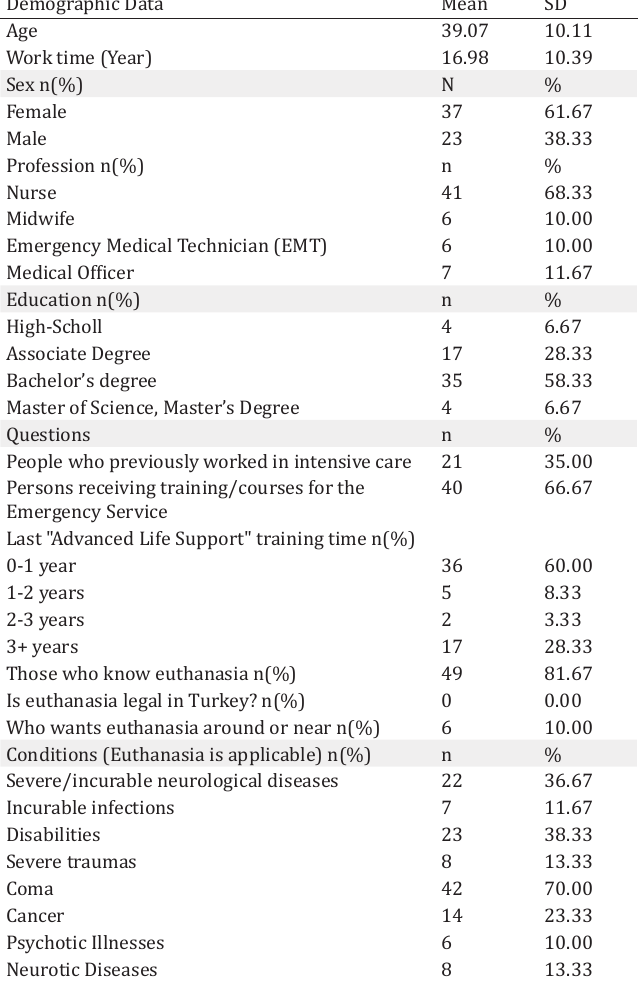
Demographic data of healthcare